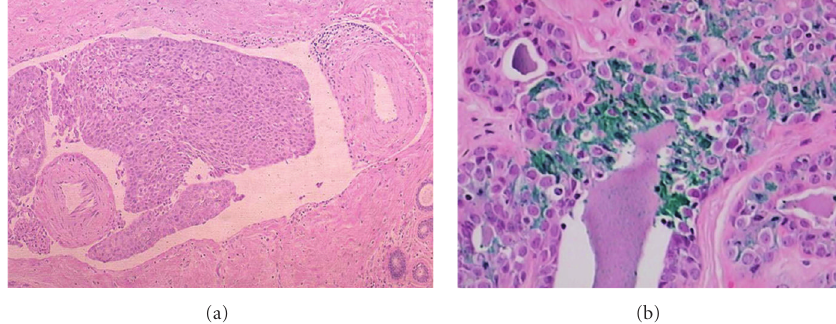
Figure 2: (a) Lymphatic invasion in a margin is not considered a “positive” margin. However, such disease present in a margin indicates the patient has high risk of both residual and systemic disease. (b) Image of lobular carcinoma in situ (LCIS) in an inked margin; however, the surgical margin is not defined as being positive for carcinoma.